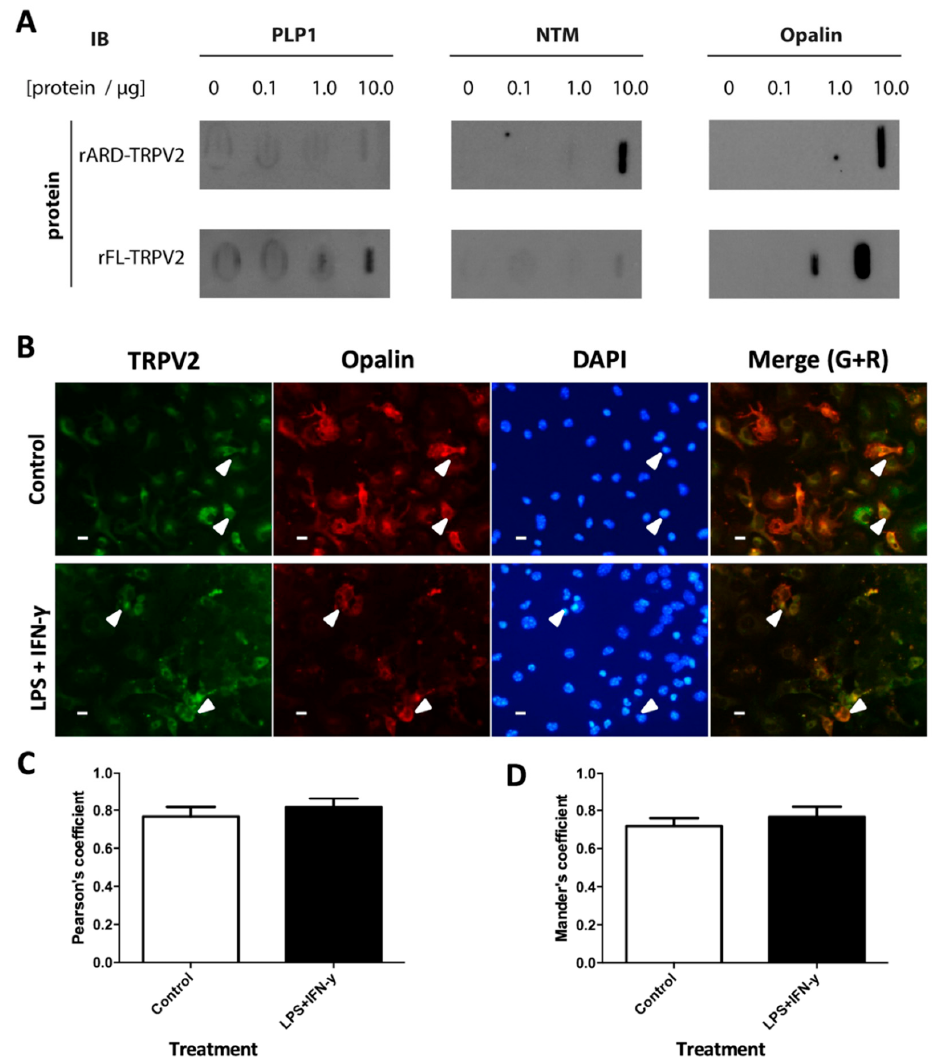
Figure 1. TRPV2 interaction with Opalin, NTM and PLP1 in vitro during basal and inflammatory conditions. ( A ) Rat TRPV2 FL protein and rat ARD of TRPV2 were immobilized on membranes and incubated with increasing concentrations of rat protein brain lysates (0–10 µg). Opalin, NTM and PLP1 were detected by immunoblot. ( B ) Immunocytochemistry in mouse mixed glial primary cultures shows TRPV2 (green), Opalin (red) and DAPI (blue). TRPV2-Opalin colocalization is shown as yellow signal (merge) and both proteins are co-expressed in some cells (arrowheads). Expression of these proteins is mainly found in the membrane. ( C ) TRPV2–Opalin colocalization expressed as Pearson’s coefficient in basal and inflammatory conditions. Both proteins show a high degree of colocalization. ( D ) TRPV2 colocalization with Opalin, expressed as Mander’s coefficient M2 (fraction of TRPV2 signal overlapping Opalin) in basal and inflammatory conditions. Both proteins show a high degree of colocalization. Results were expressed as mean ± SEM. Statistical analysis of the results were performed with an unpaired Student’s t -test ( p < 0.05 is statistically significant). Scale bar = 20 µm.